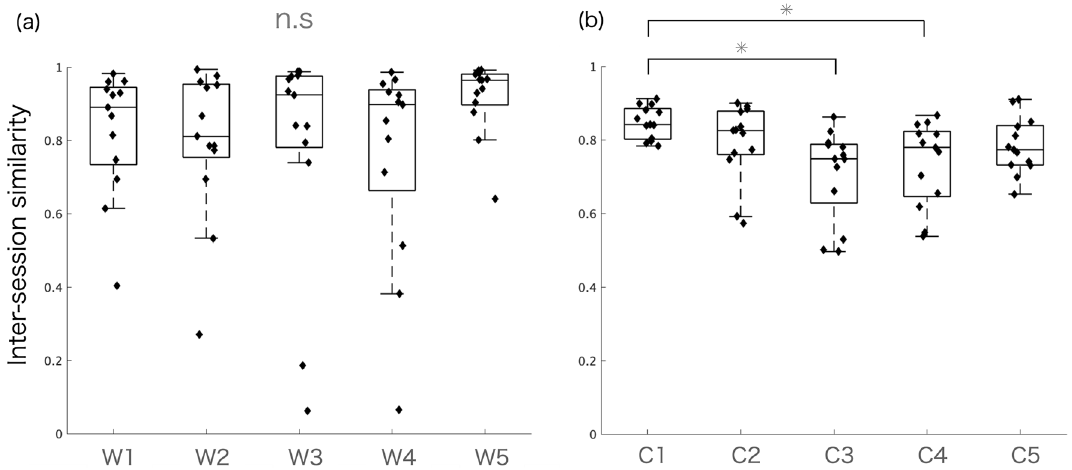
Figure 7. Inter-session similarity of ( a ) muscle synergies (W1–W5) and ( b ) temporal patterns (C2–C5). Kruskal–Wallis test showed p = 0.2084 for W and p < 0.05 for C. Multiple comparisons show statistically significant differences in C as follows: C1 and C3 and C1 and C4 (p <